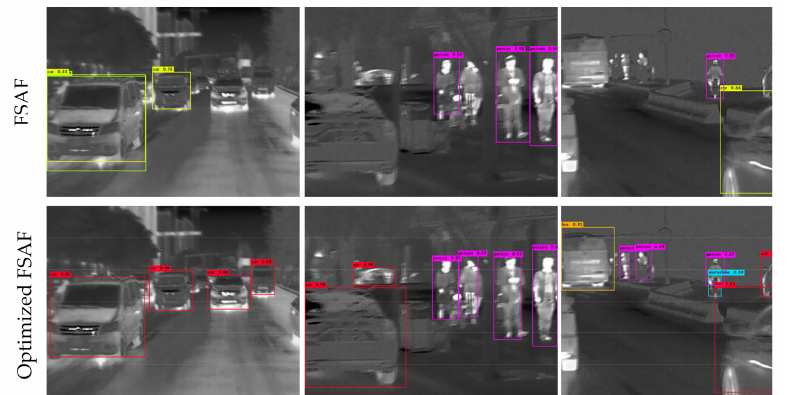
Figure 4. Qualitative test results of the FSAF module and our optimized FSAF module. Both are using DarkNet-53 as the backbone.